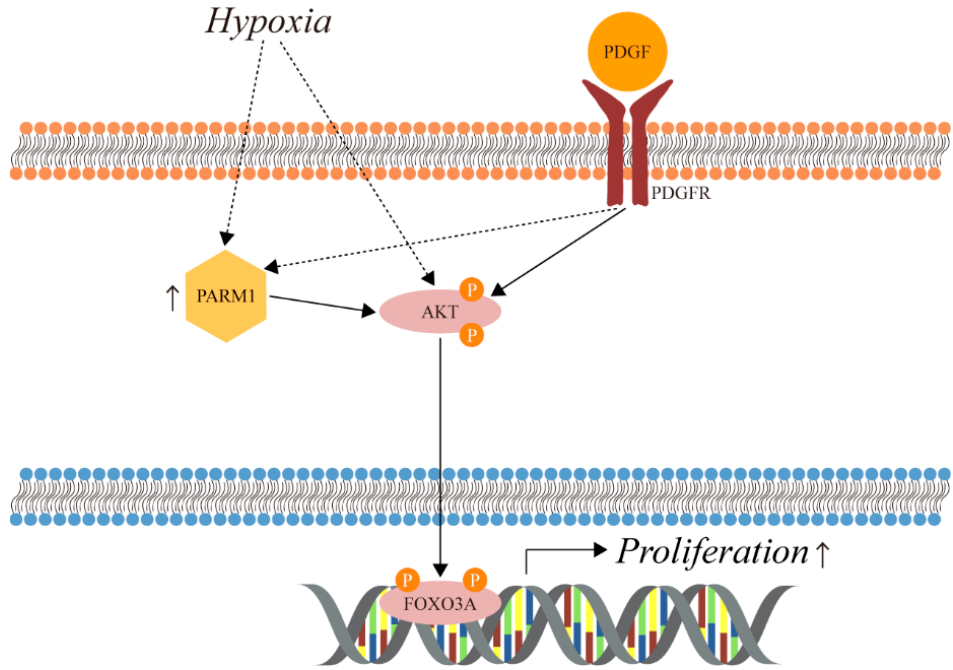
Figure 9. Schematic illustration shows PARM1 promoting proliferation in the pulmonary arterial hypertension via the AKT/FOXO3A pathway in PASMC. P signi fi es